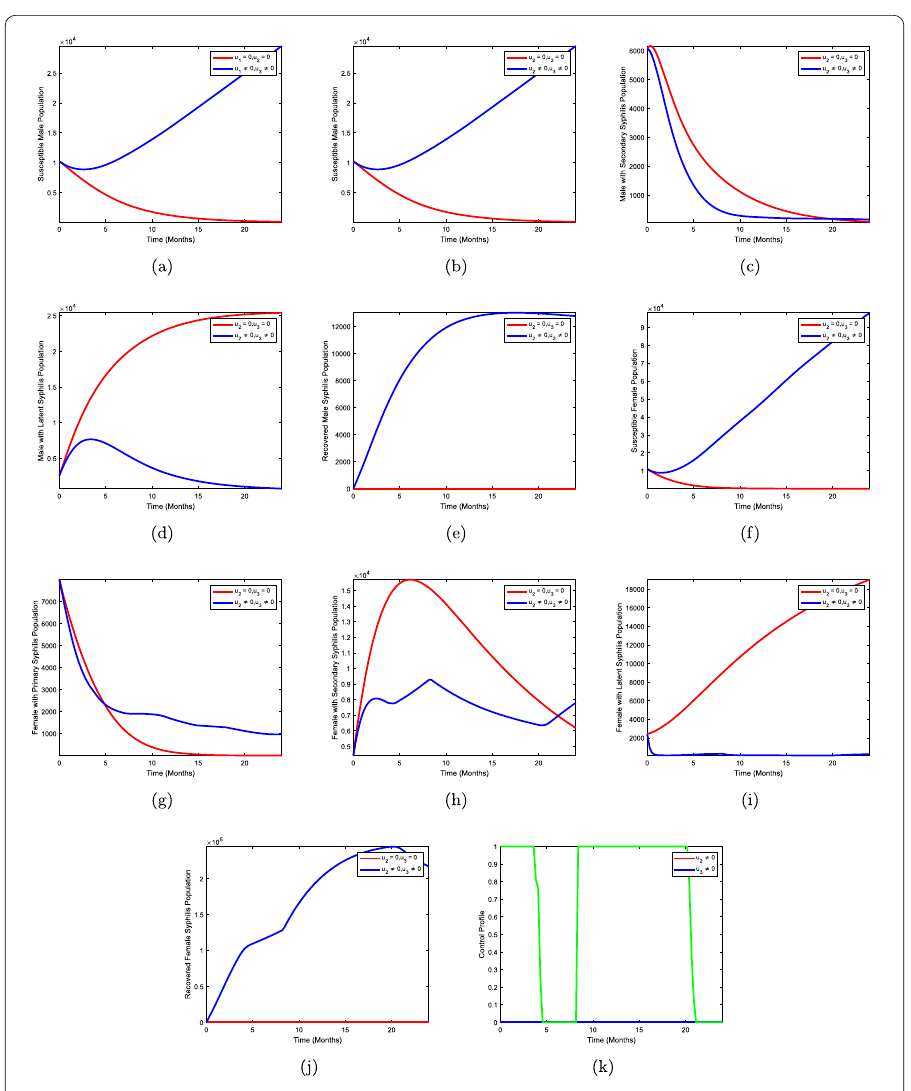
Figure 4 Treatment of male with syphilis infection + treatment of female with syphilis infection